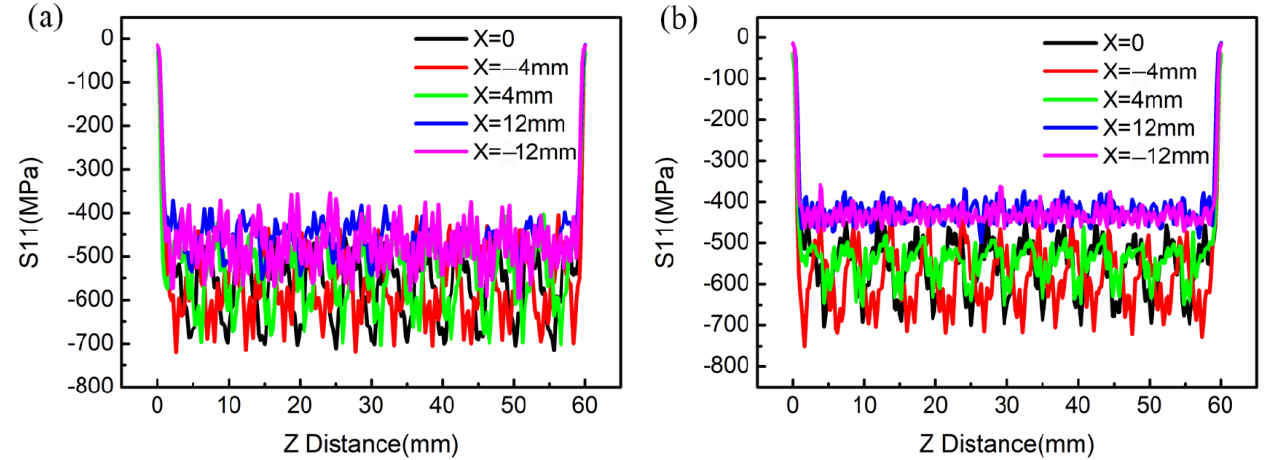
Figure 5. Residual stress distributions along the paths ( a ) on the upper surface and ( b ) on the lower surface.